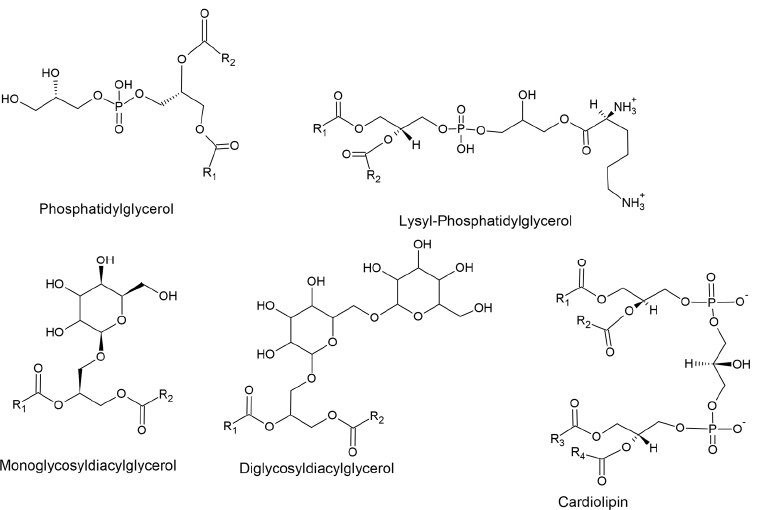
Figure 10. Structure of bacterial membrane